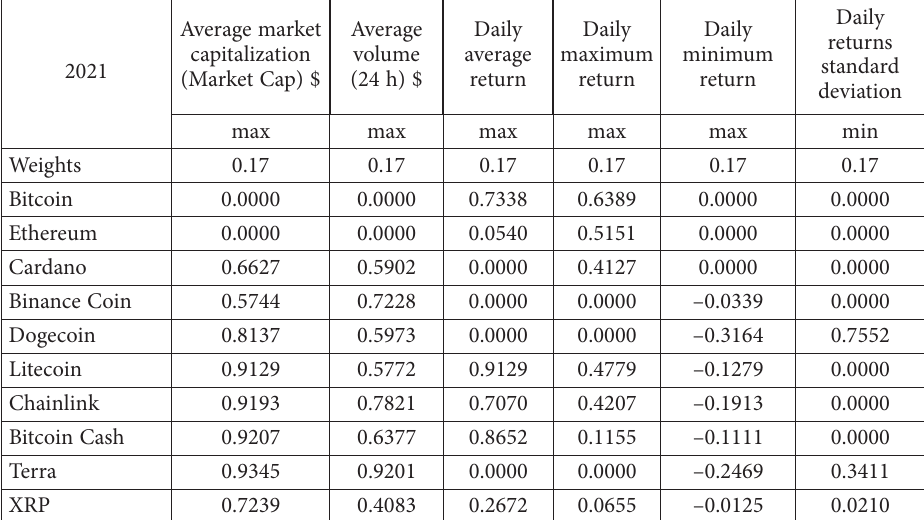
Table 4. NDA ij (source: compiled by the